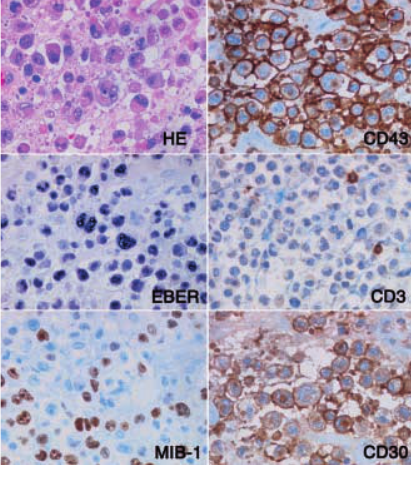
Figure 3 Photomicrographs of the intrathoracic tumour (original magnification 400 (cid:2) ): haematoxylin and eosin staining (H&E) showing anaplastic cytological features; positivity for CD43 and CD30, negativity for CD3 and detection of an intermediate MIB-1 proliferation fraction by immunohistochemistry, consistent with plas- mablastic differentiation; positive staining of nuclei of neoplastic cells in EBV in situ hybridi- sation for EBER, characteristic of pyothorax as- sociated large B cell